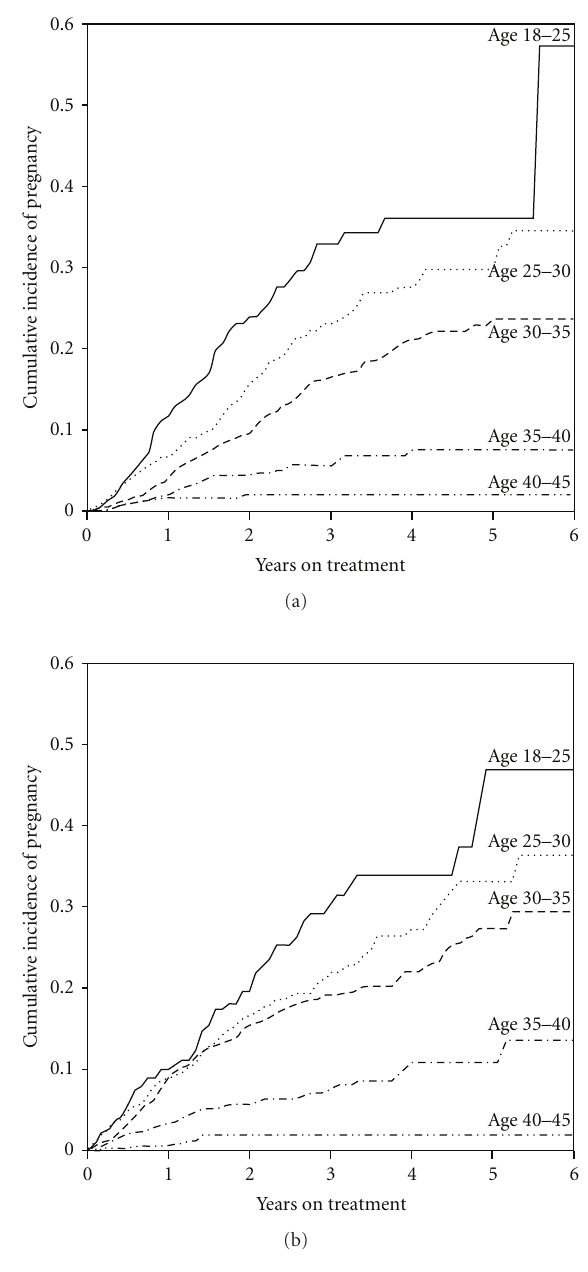
Figure 2: Cumulative incidence of first pregnancy among 5,996 women initiating HAART in Johannesburg, South Africa, from time of HAART initiation, by baseline age and baseline CD4 count: (a) ≤ 100 cells/mm 3 ; (b) > 100 cells/mm 3 . Curves are estimated using the extended Kaplan-Meier